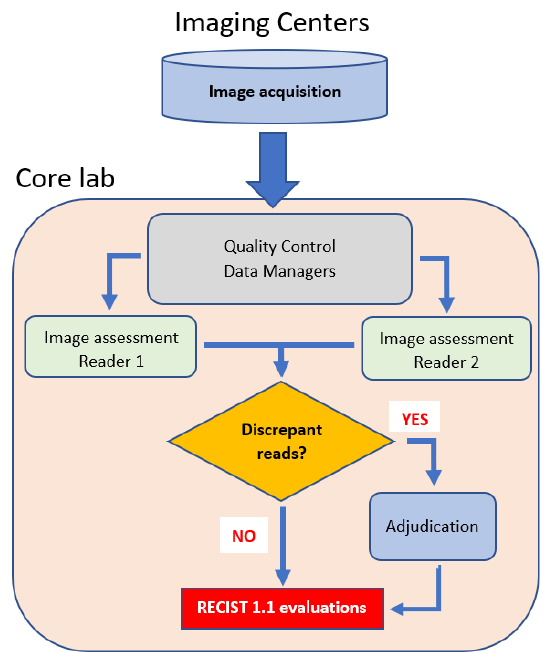
Figure 1. Workflow of the BICR with double reads and